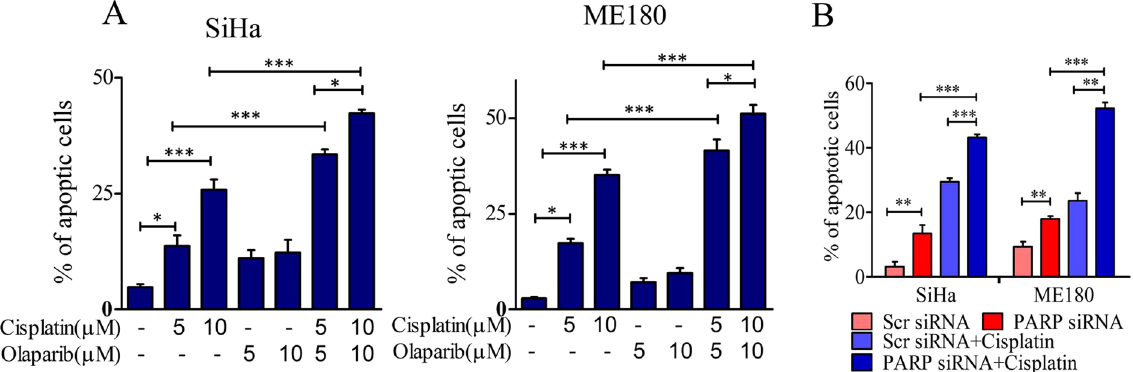
Figure 9. PARP1 inhibition or silencing enhances cisplatin induced apoptosis in cervical cancer cells. ( A ) Bar graph showing quantification of apoptotic cells in cisplatin and/or olaparib treated cells in both the cell lines.